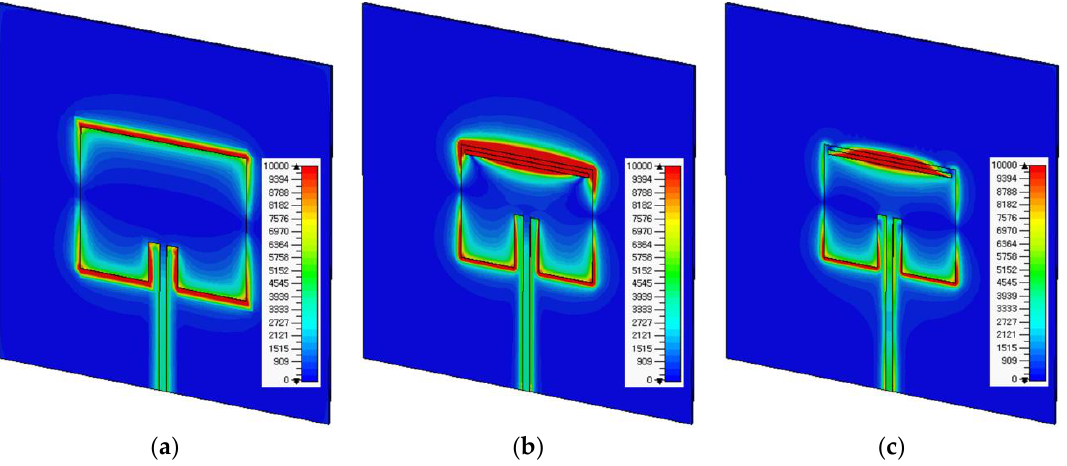
Figure 4. Electric field distributions of ( a ) conventional patch antenna at resonant frequency f r1 = 2.5 GHz; ( b ) proposed slot-loaded patch antenna at f r1 = 2.5 GHz; ( c ) proposed slot-loaded patch antenna at f r2 = 3.465 GHz.